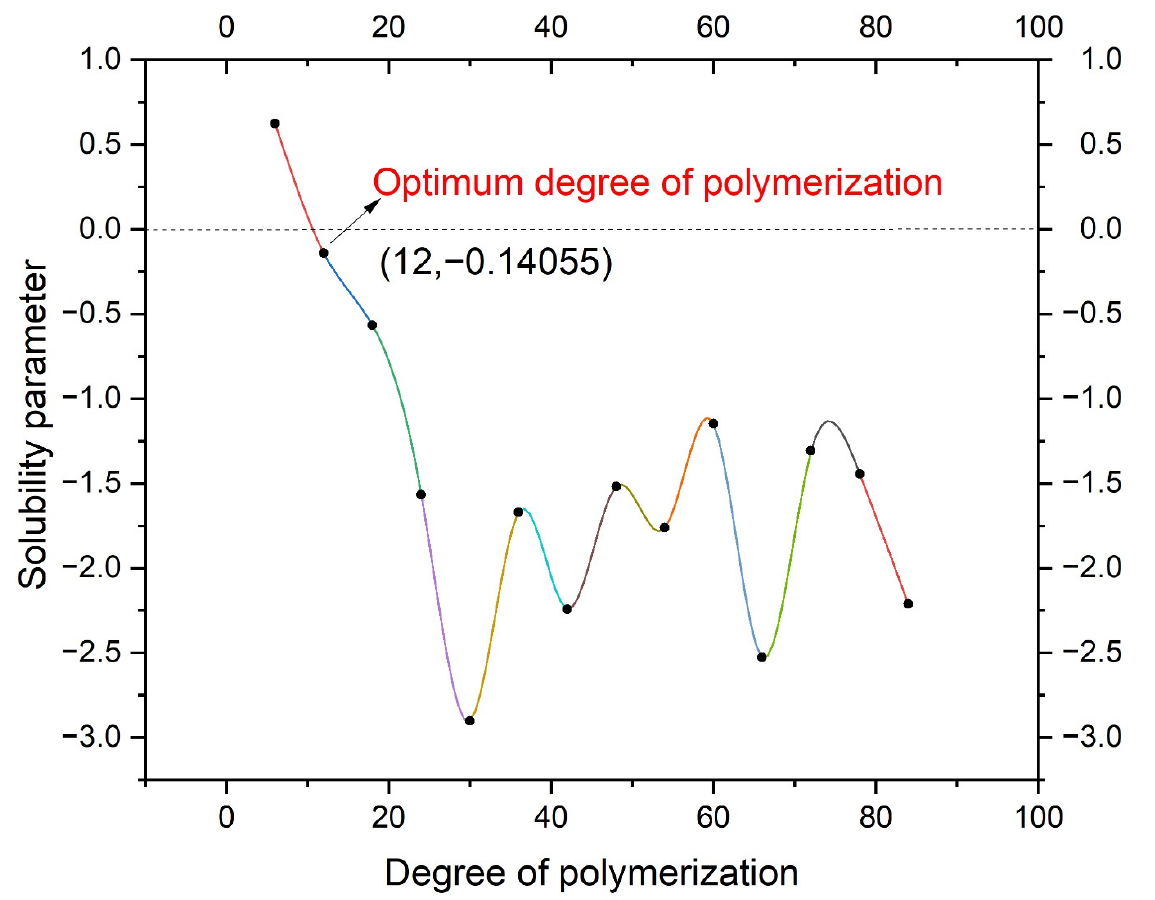
Figure 7. The difference in the solubility